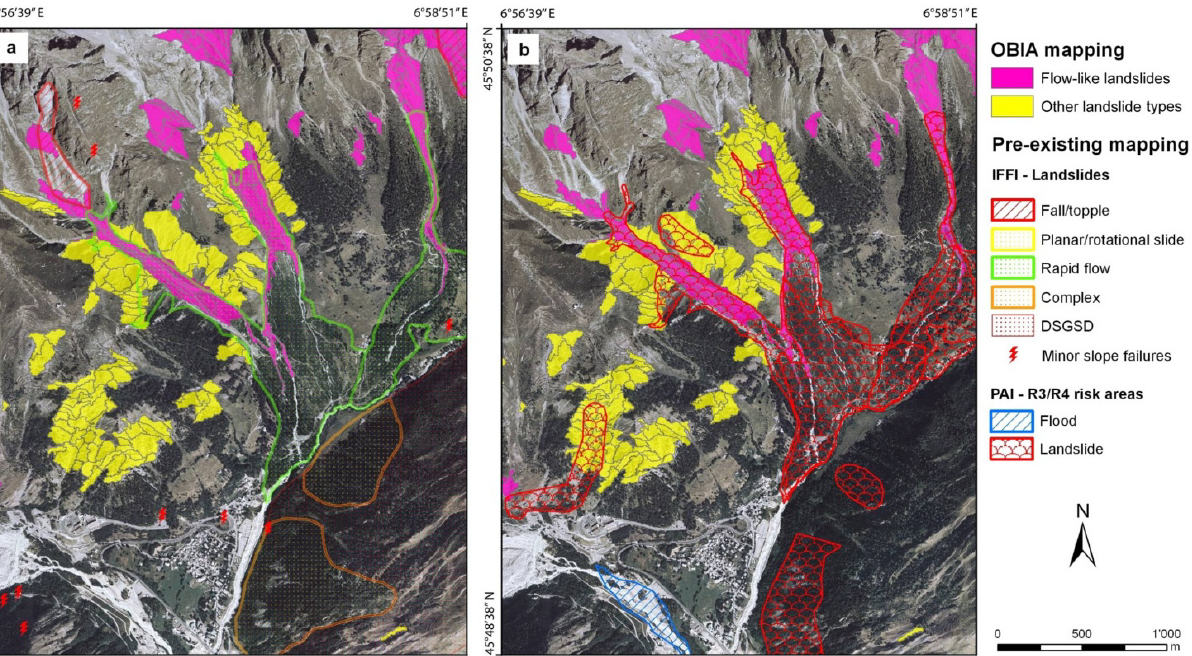
Figure 10. Comparison of OBIA results, ( a ) IFFI and ( b ) PAI maps in the lower Ferret